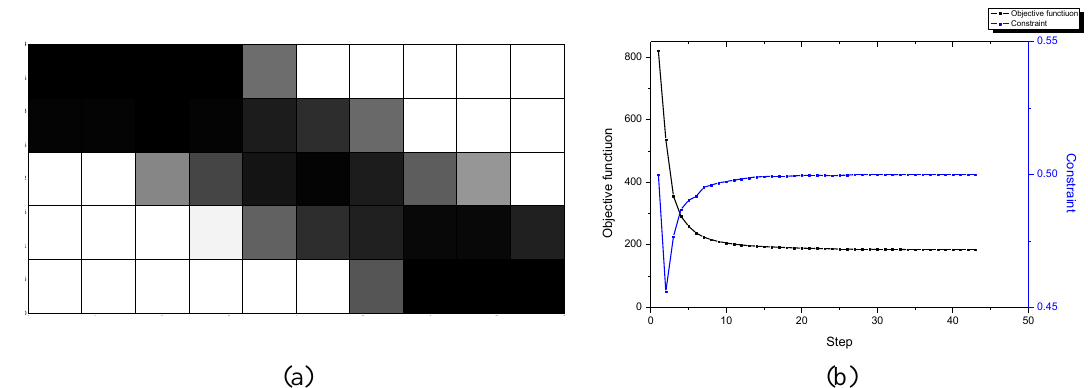
Figure 7. Optimized results for Michell-type structure with static analysis: ( a ) Optimized layout ( b ) convergence history.